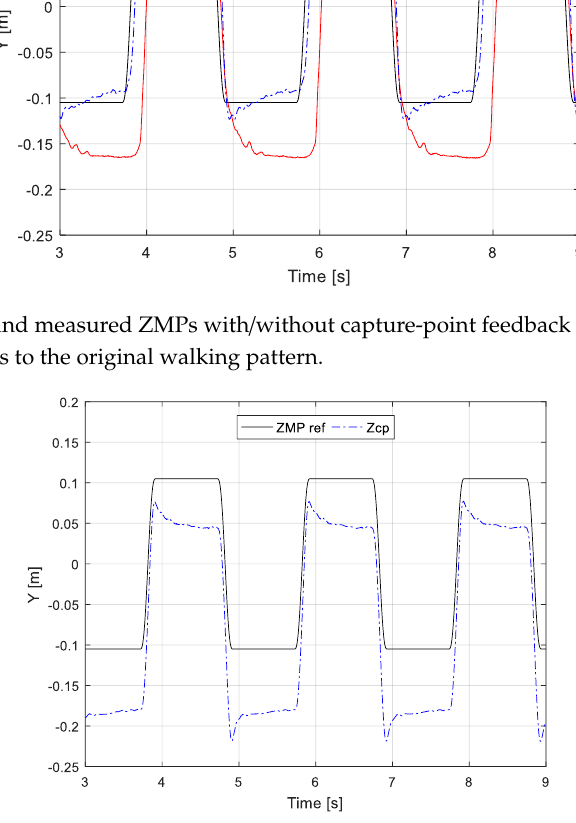
Figure 10. Generated 𝒛 𝐜𝐩 by capture-point feedback.